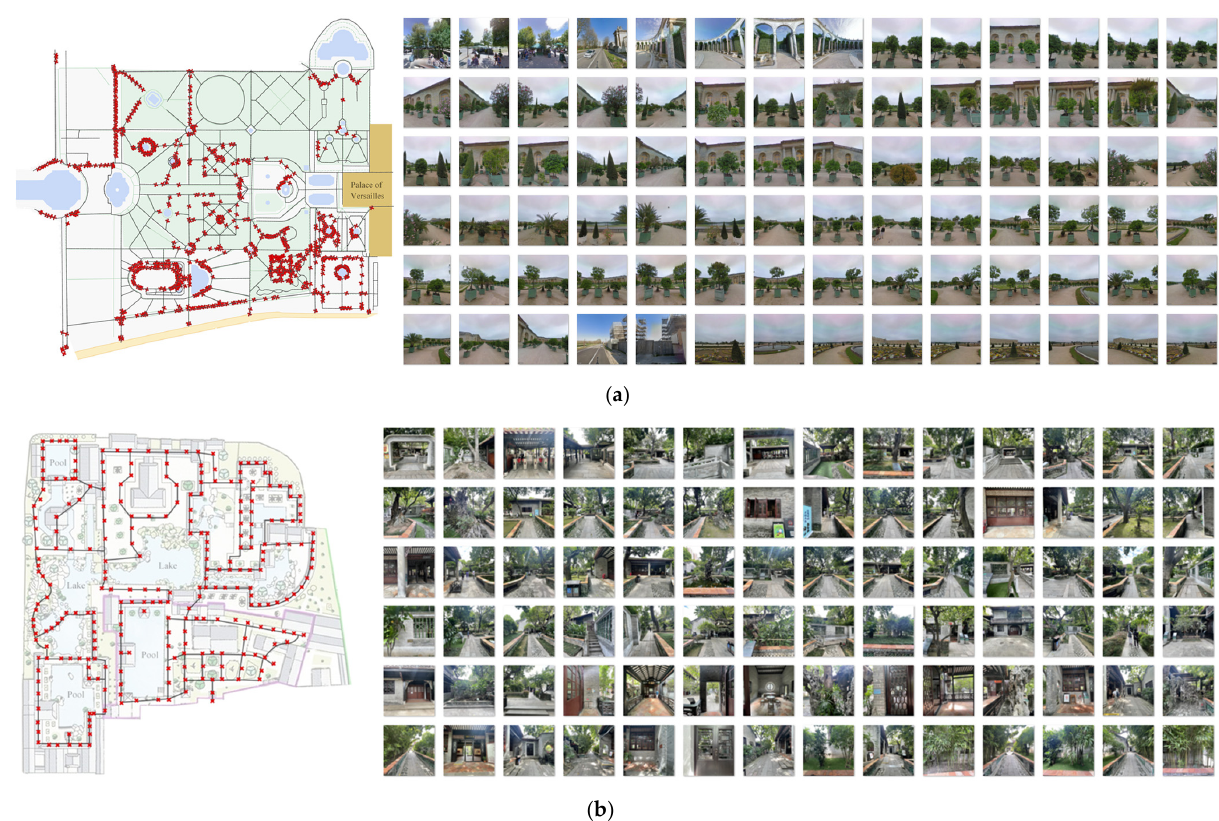
Figure 7. The distribution of ‘Diverse’ scenario and its sample images in Gardens of Versailles ( a ) and the Qinghui Garden ( b ). 4.